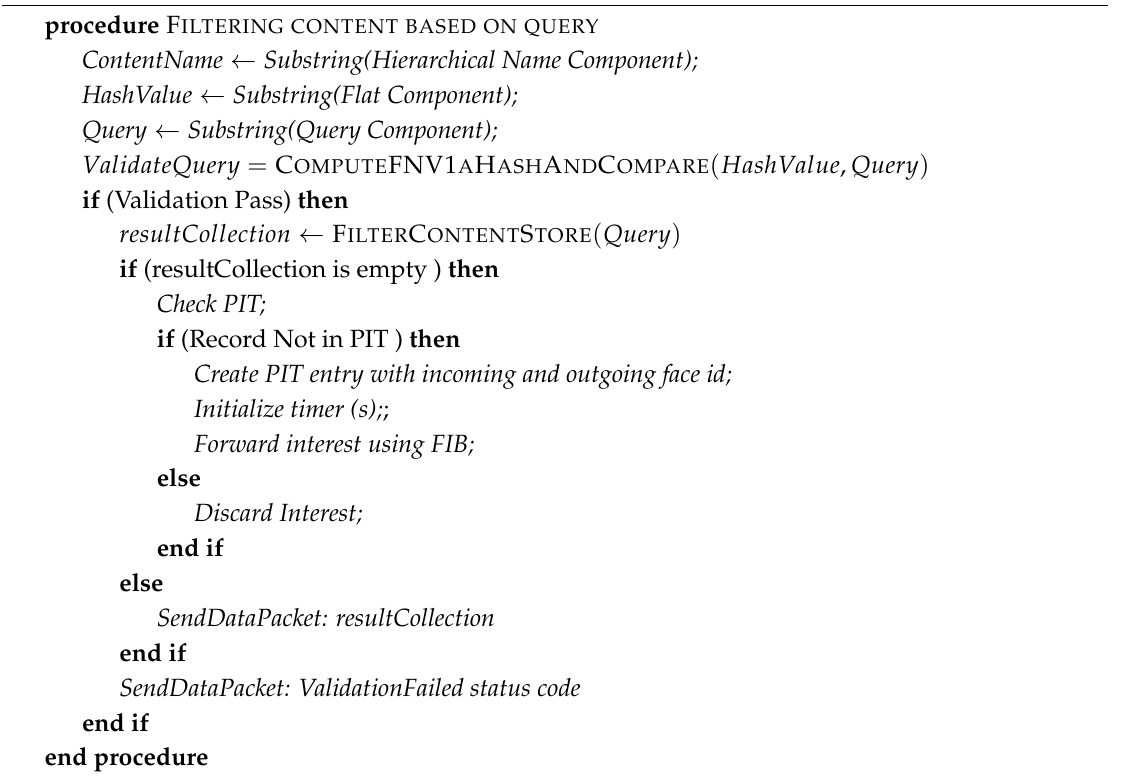
Algorithm 2 Received Interest (Query) in the Proposed NINQ procedure F ILTERING CONTENT BASED ON